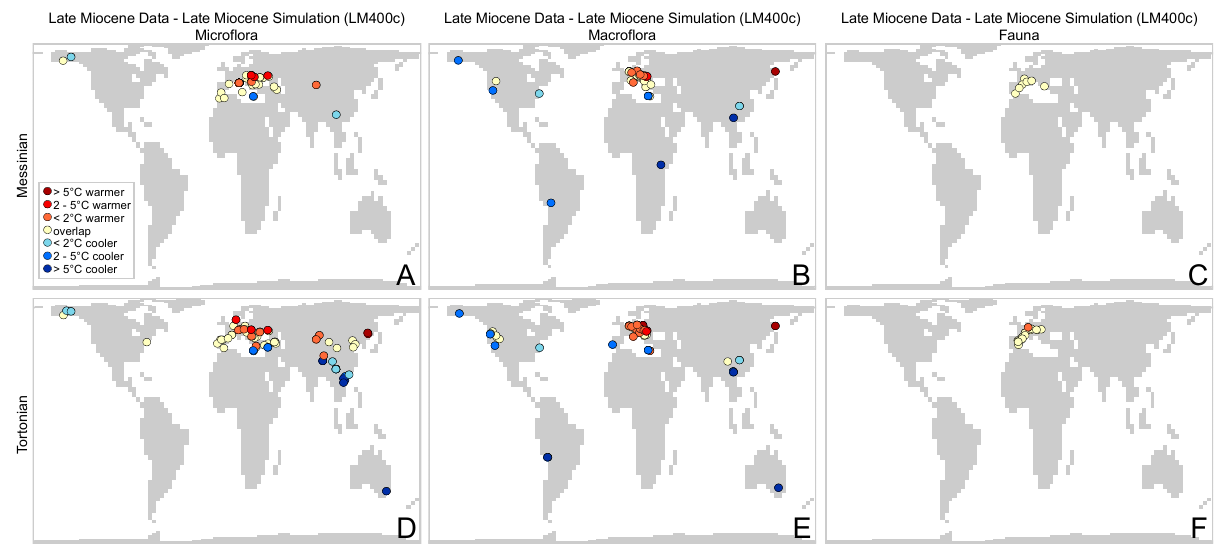
Fig. 9. Results from the model–data comparison for mean annual temperature, late Miocene data (LM400c).